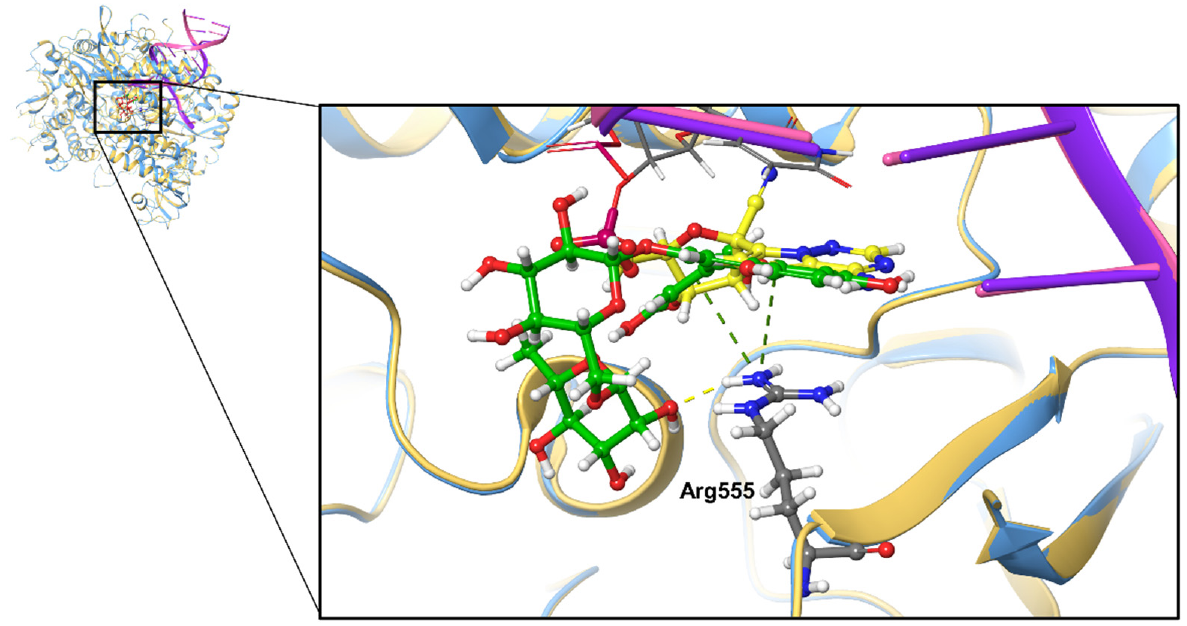
Figure 4. Superposition of cyanidin 3- O -rutinoside docked onto SARS-CoV-2 RdRp (7BV2) and cryo-EM structure of SARS-CoV-2 RdRp with remdesivir-MP (7BV2). The yellow-colored compound represents remdesivir-MP on 7BV2 (yellow-colored); the green-colored compound represents cyanidin 3- O -rutinoside docked on 7BV2 (blue-colored). The yellow dash line represents a hydrogen bond, and the green dash line represents a π –cation interaction.